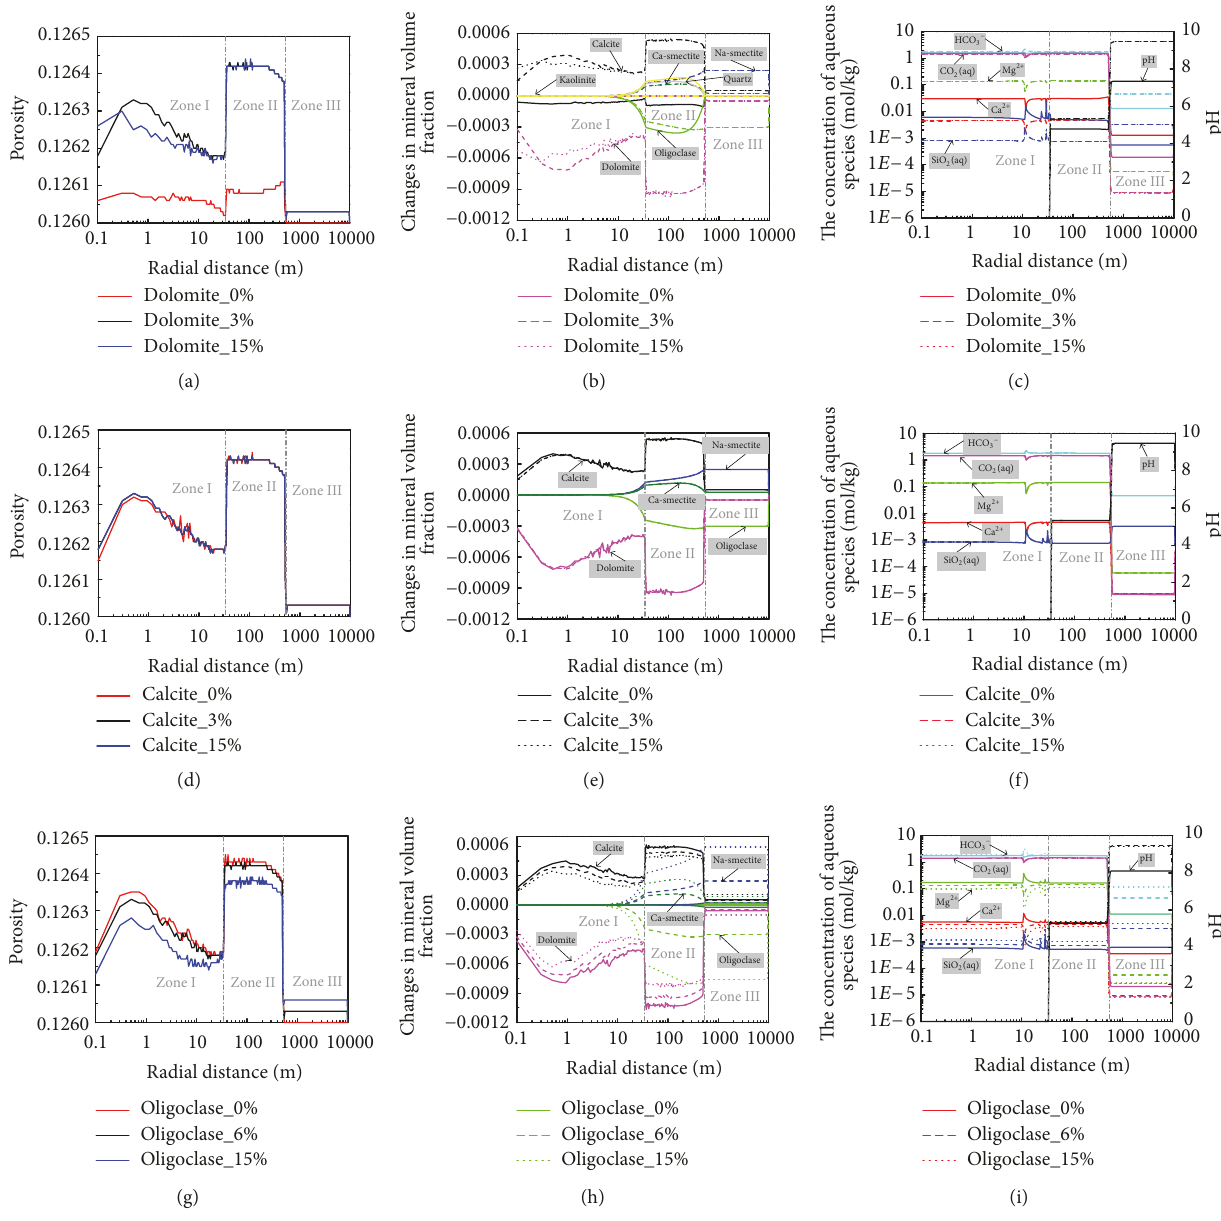
Figure 4: The horizontal distribution of changes in porosity, mineral volume fraction, and concentrations of major aqueous species and pH for different amounts of dolomite (a, b, and c), calcite (d, e, and f), and oligoclase (g, h, and i) at the depth of − 75 m after 30 years of CO 2